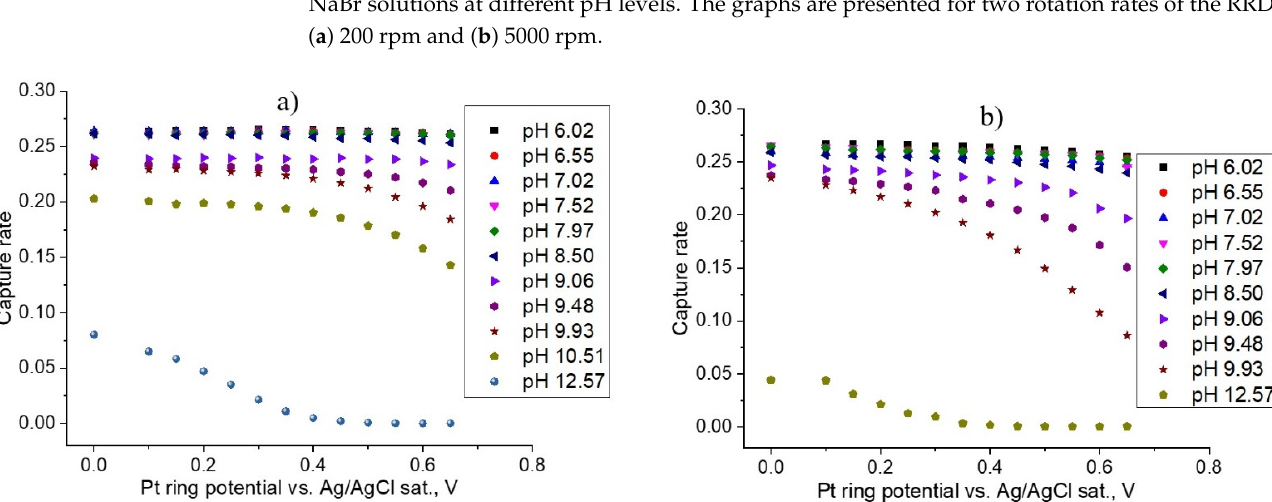
Figure 8. Ring collection efficiencies on the Pt ring under the applied 10 mA on the GC disk for 1 M NaBr solutions at different pH levels. The graphs are presented for two rotation rates of the RRDE: ( a ) 200 rpm and ( b ) 5000 rpm.